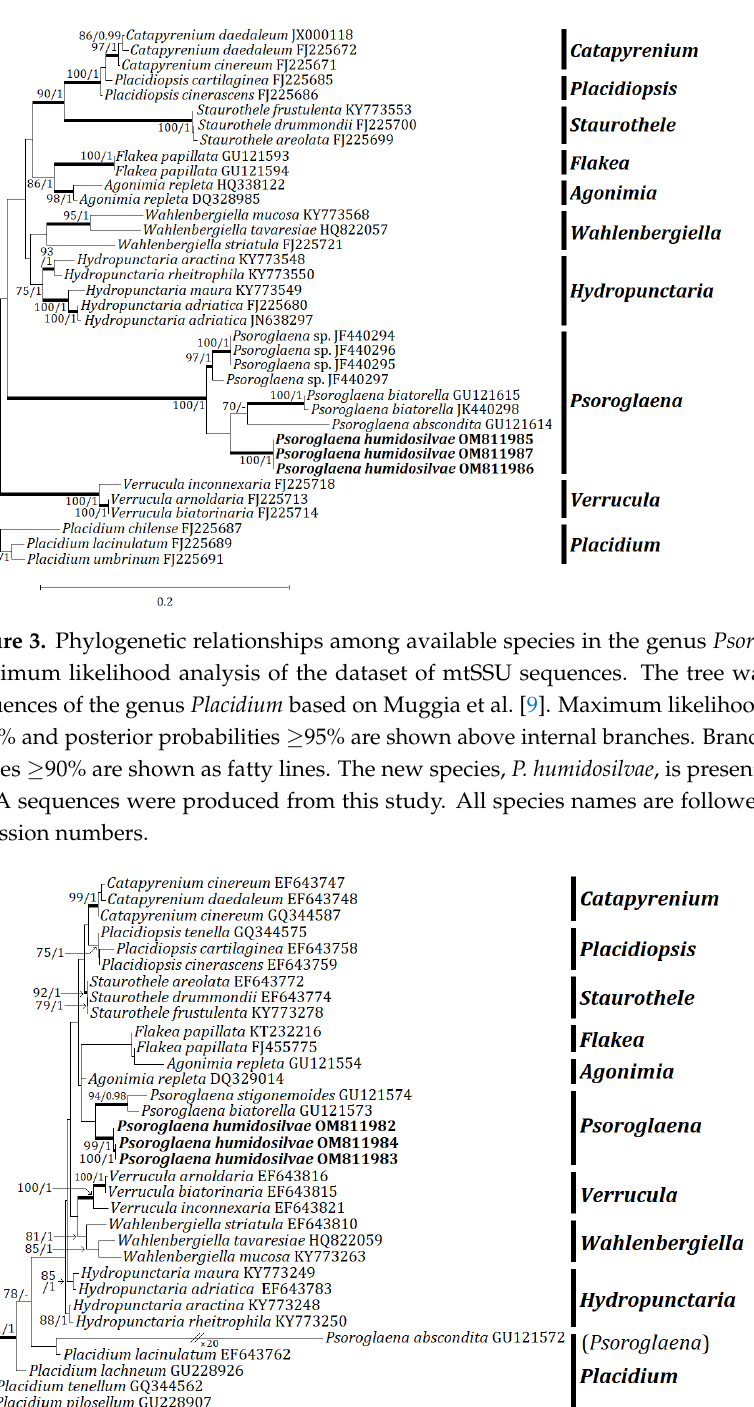
Figure 2. Phylogenetic relationships among available species in the genus Psoroglaena based on a maximum likelihood analysis of the dataset of ITS sequences. The tree was rooted with the se- quences of the genus Placidium based on Muggia et al. [9]. Maximum likelihood bootstrap values ≥70% and posterior probabilities ≥ 95% are shown above internal branches. Branches with bootstrap values ≥90% are shown as fatty lines. The new species, P. humidosilvae , is presented in bold as their DNA sequences were produced from this study. All species names are followed by the GenBank accession numbers.